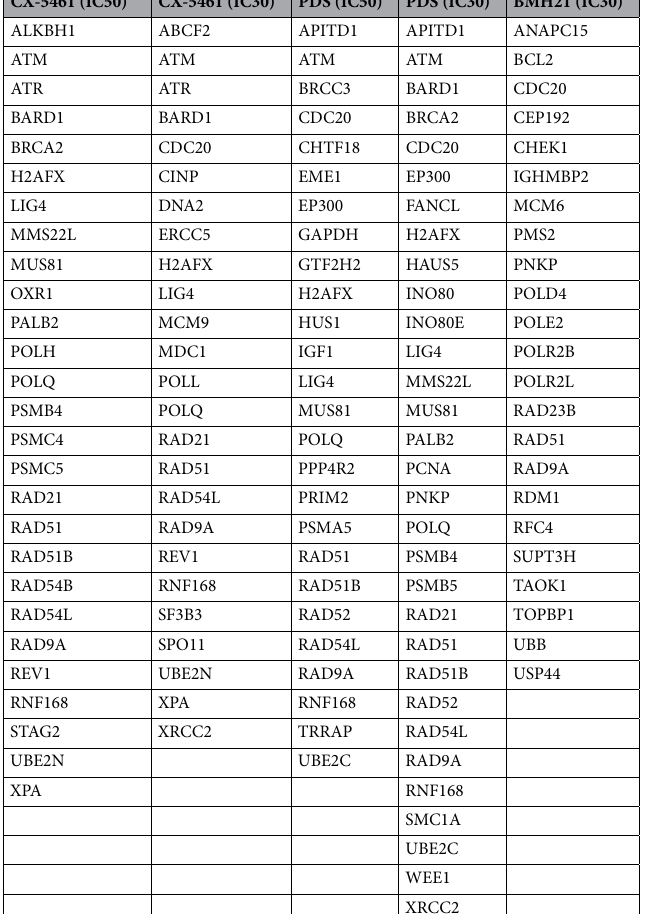
Table 2. Top depleted genes for each drug